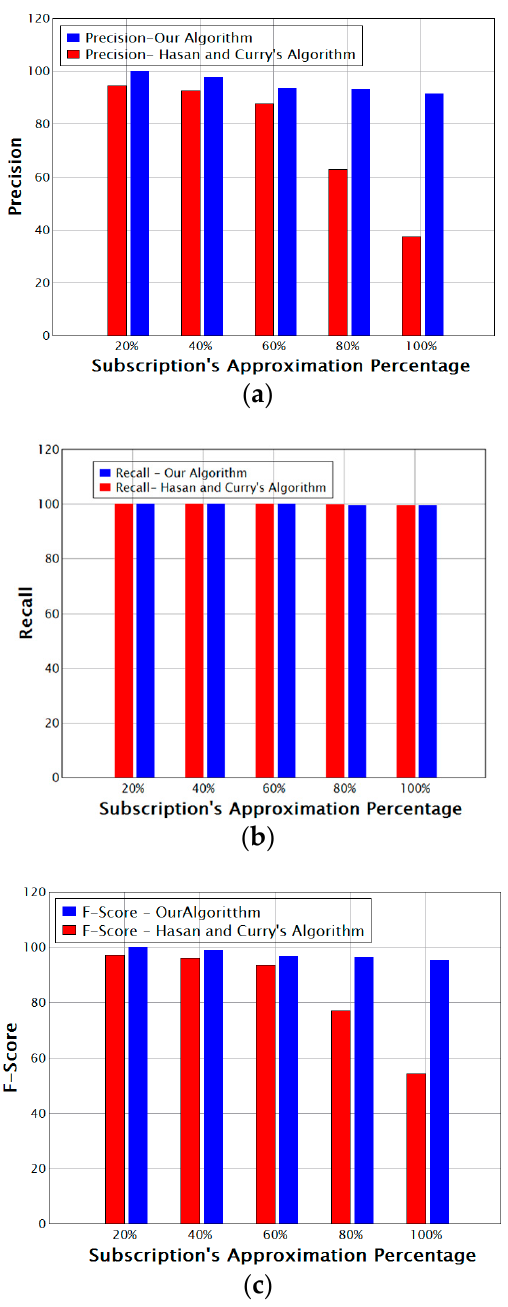
Figure 6. Comparison of Effectiveness Measures for our Algorithm vs. the algorithm of Hassan and Curry; ( a ) Comparison of Precision; ( b ) Comparison of Recall; ( c ) Comparison of F-Score.